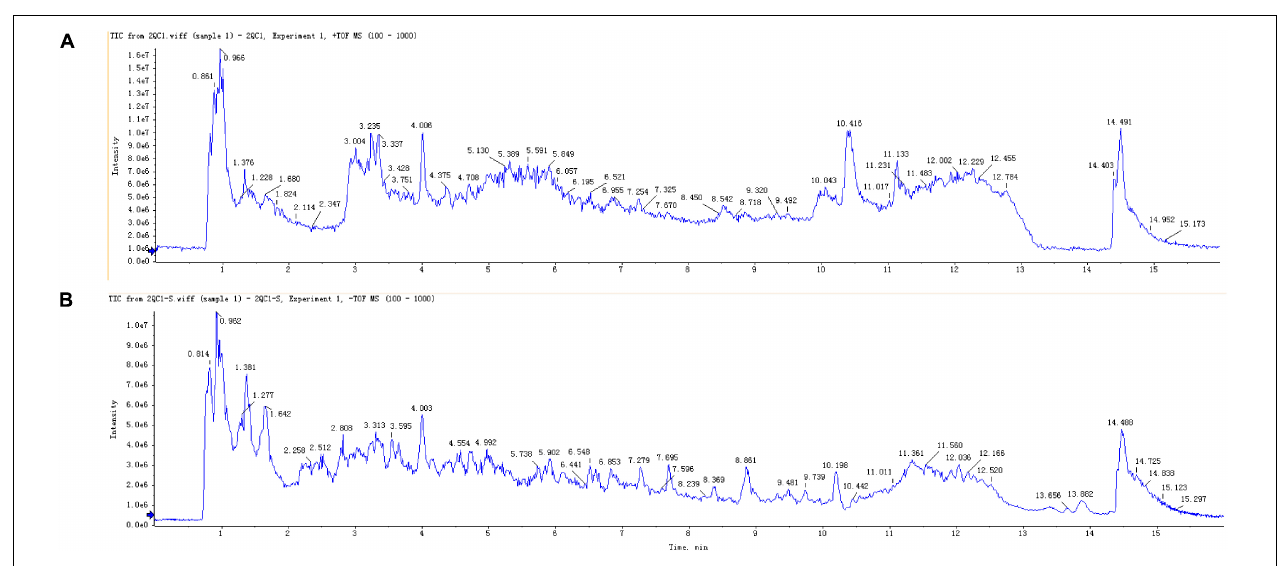
FIGURE 1 | Total ions chromatogram of P. sibiricum. (A) Positive ions. (B) Negative ions.